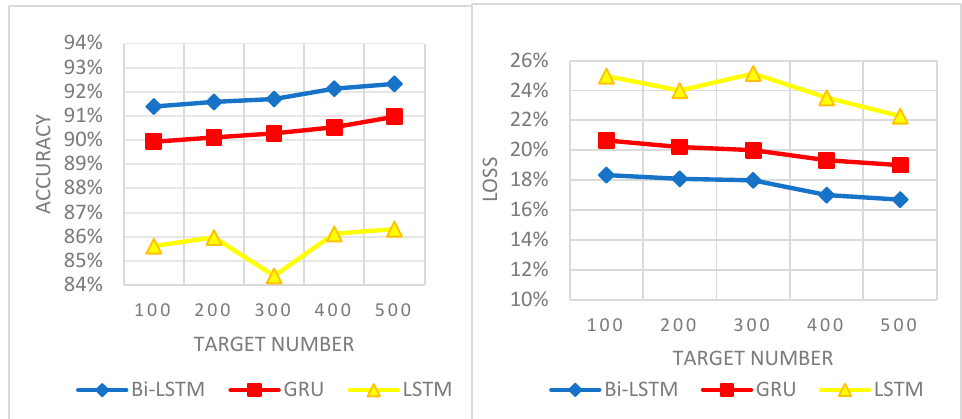
Figure 8. Model performance comparison.